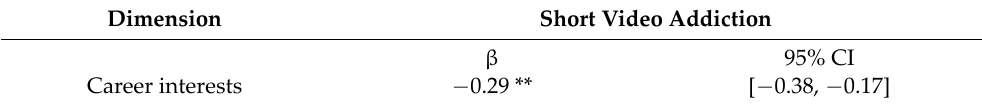
Table 3. Indirect Effect